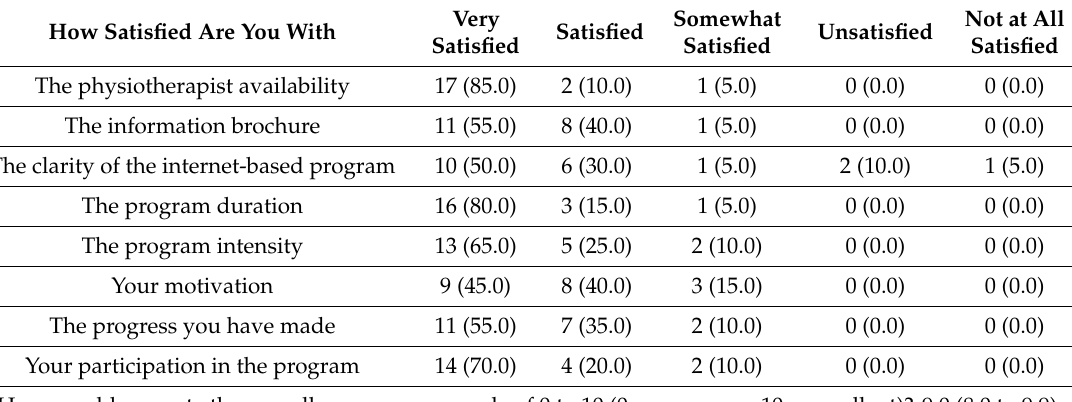
Figure 1. Participant flow chart. Table 1. Results of the satisfaction questionnaire ( n = 20).